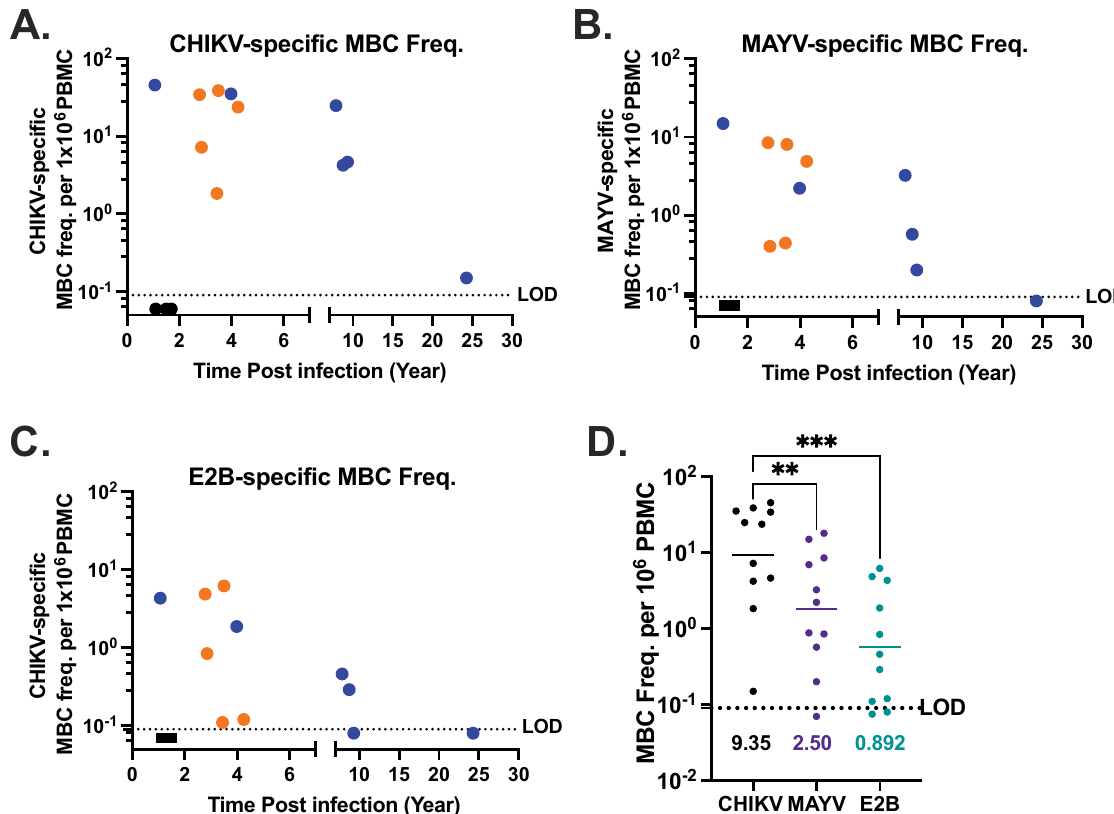
Fig 6. Antigen-specific MBC frequency per 10 6 PBMC over time in non-endemic cohort (blue n = 6), endemic (orange n = 5), and na ï ve subjects (black n = 3). (A) CHIKV-specific MBC frequency as determined by whole CHIKV-ELISA. (B) MAYV-specific MBC frequency determined by whole MAYV-ELISA. (C) E2B-specific MBC frequency determined by MAYV-E2B ELISA. Negative samples and those below the limit of detection were assigned an arbitrary value between 0.05 and 0.09 (LOD = 0.1). (D) Summary of antigen-specific MBC frequency for CHIKV, MAYV, and MAYV E2B with subjects grouped together. Geometric mean frequencies are reported on the graph. P values are the result of a one-way ANOVA �� p = 0.0044, ��� p = 0.006.